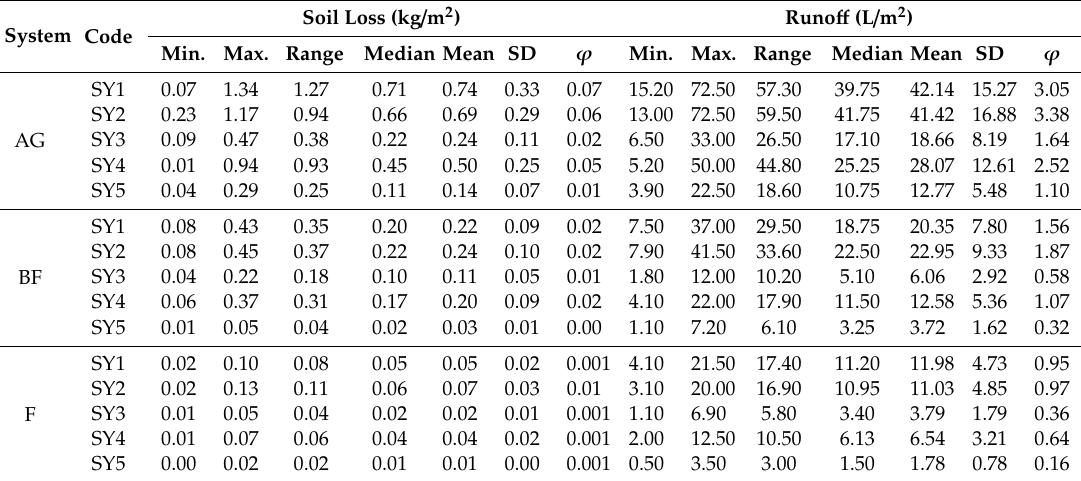
Table 3. Univariate statistics of observed soil loss and runo ff in the studied locations (SY1-SY5) under three land uses (AG: agricultural land, BF: burnt forest, F: